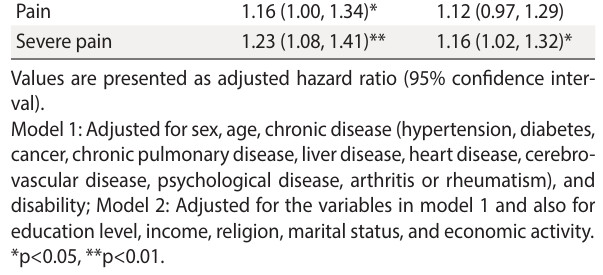
Table 2. Mortality risk according to pain phenotype Phenotype